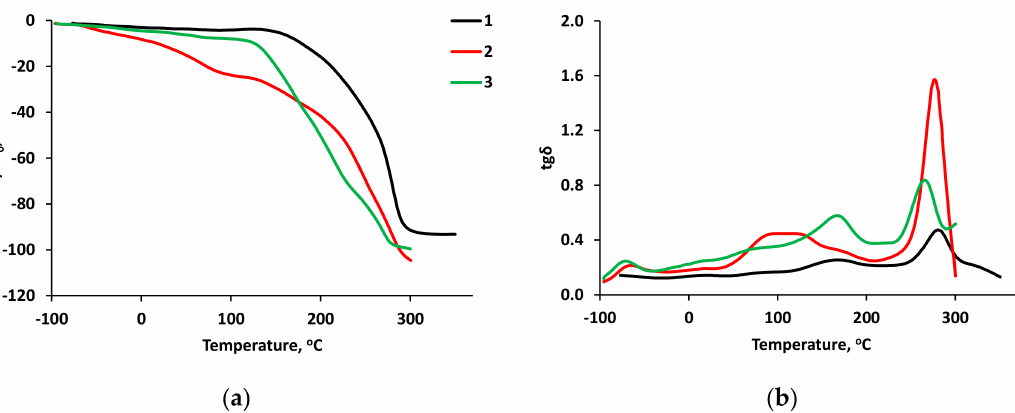
Figure 14. TMA curves ( a ) and temperature dependences of the mechanical loss tangent ( b ) of polymers based on [PPEG]:[TDI] = 1:12